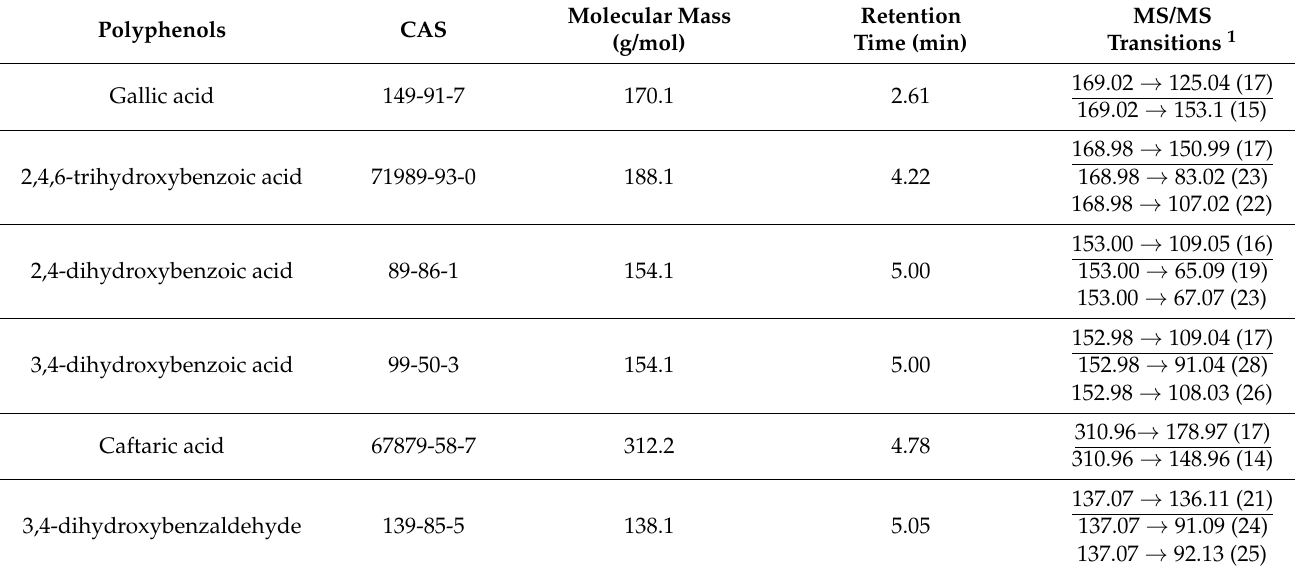
Table 4. Target polyphenols: CAS number, molecular mass, retention time and SRM transitions (precursor ion → product ion (collision energy,